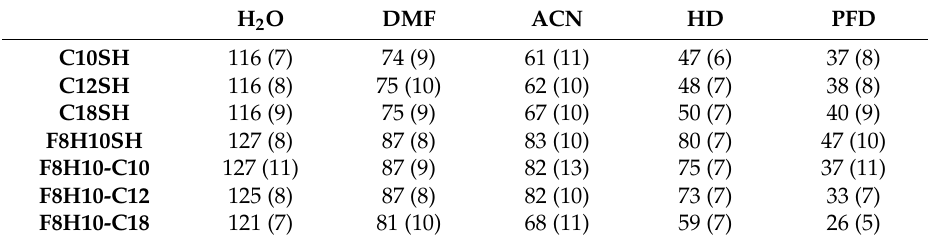
Figure 7. Advancing contact angle data obtained for water (H 2 O), N , N -dimethylformamide (DMF), acetonitrile (ACN), hexadecane (HD), and perfluorodecalin (PFD) on SAMs derived from the monodentate thiols ( C10SH , C12SH , C18SH , and F8H10SH ) and the F8H10-Cm dithiols ( F8H10-C10 , F8H10-C12 , and F8H10-C18 ). Table 5. Advancing contact angles ( θ a , ◦ ) on the indicated SAMs using various probe liquids with hysteresis values ( ∆ θ = θ a − θ r ) a given in